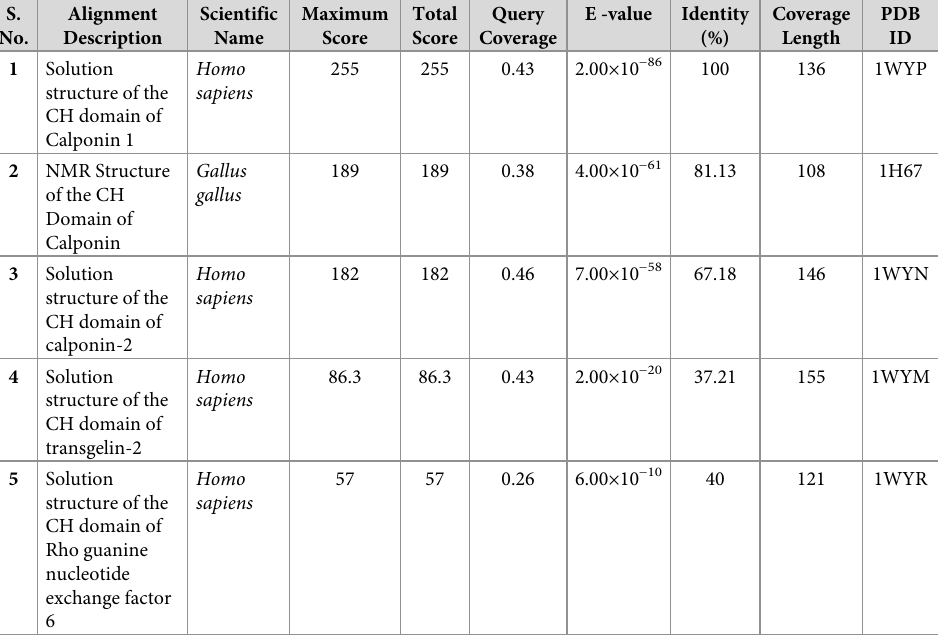
involved in beta-turn and random coil were 48.01% (133 residues). CNN1 isoform 2 was found to be the highly expressed protein (in female reproductive tissues) with maximum struc- tural coverage available on PDB database (Table 6). Therefore, the template selection for the homology modeling of CNN1 isoform 2 was carried by BLAST tool (Table 7). Top 5 alignment descriptions were used in which the highest similarity was seen with the solution structure of